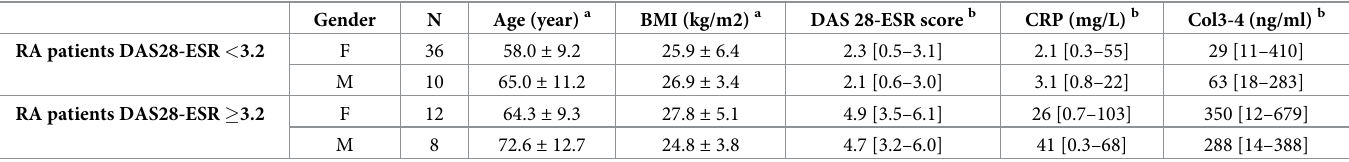
Table 4. Demographical and biological variables in patients with RA with low and high disease activity by